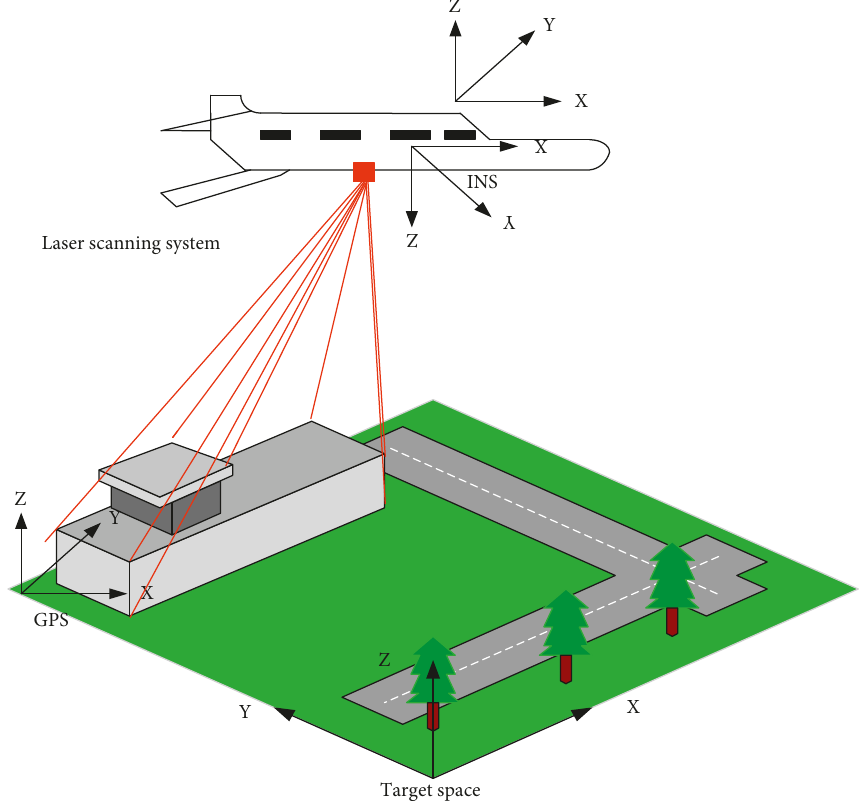
Figure 1: Airborne LiDAR technology